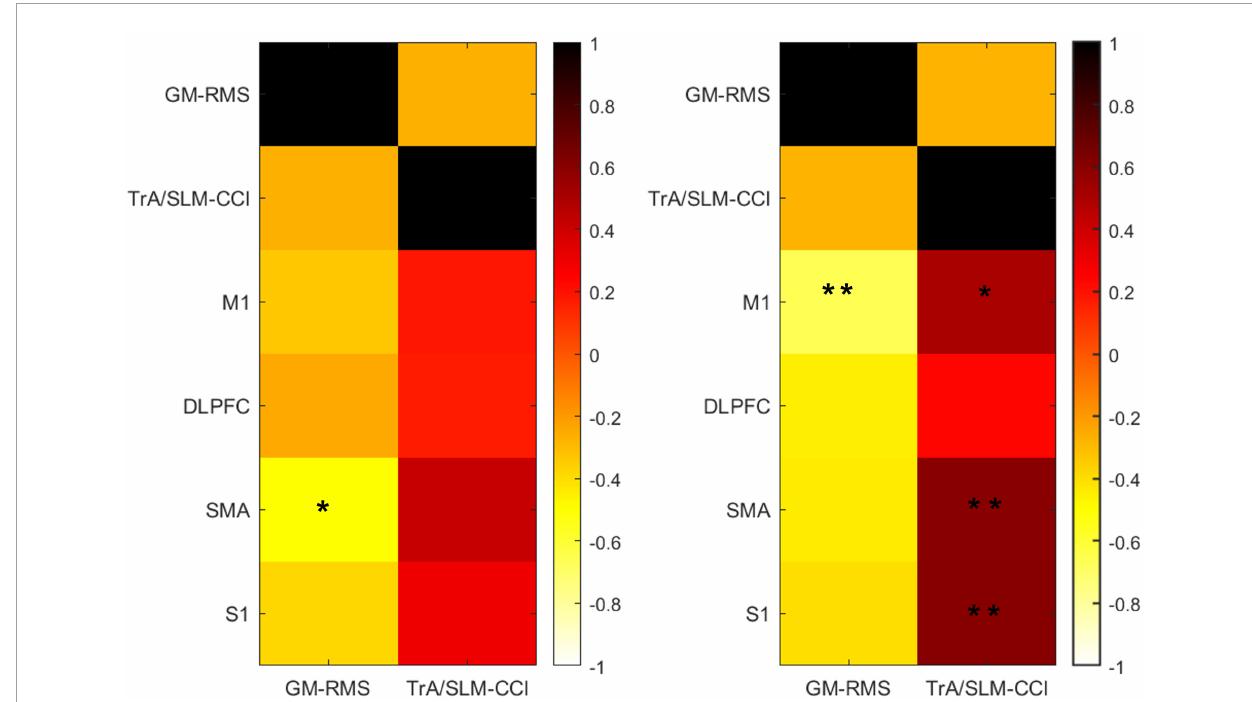
FIGURE5 The correlation between the muscle activity and the HbO change among the ROIs before (left) and after (right) iTBS in the right-leg standing tasks. HbO, concentrations of oxyhemoglobin; RMS, root mean square; CCI, co-contraction index; TrA, transversus abdominis muscle; SLM, superficial lumbar multifidus; GM, gastrocnemius medialis muscles; DLPFC, dorsolateral prefrontal cortex; M1, primary motor cortex; SMA, supplementary motor area; S1, Primary somatosensory cortex. *p < 0.05, **p <